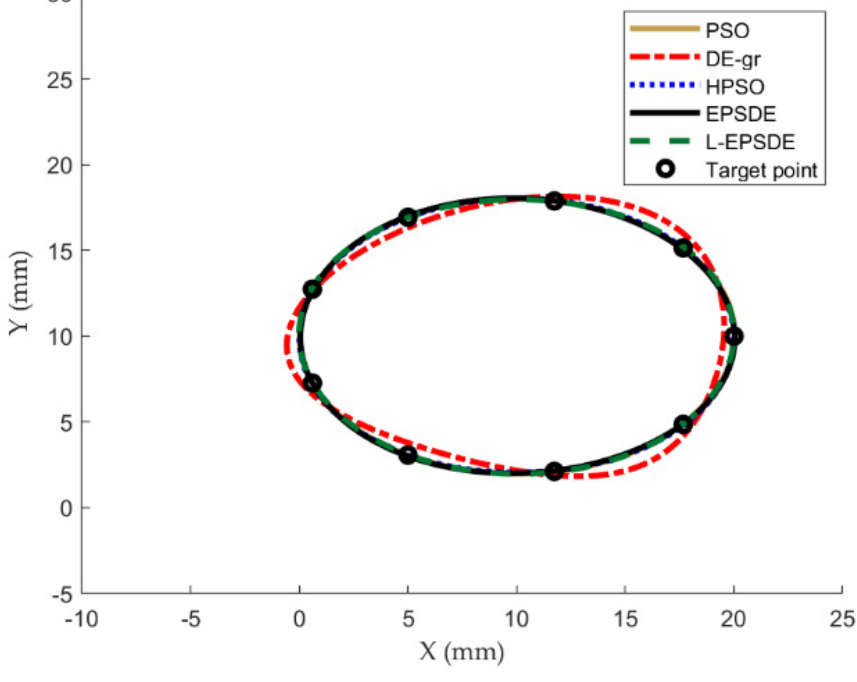
Figure 20. Trajectories of the coupler point of Case 5.